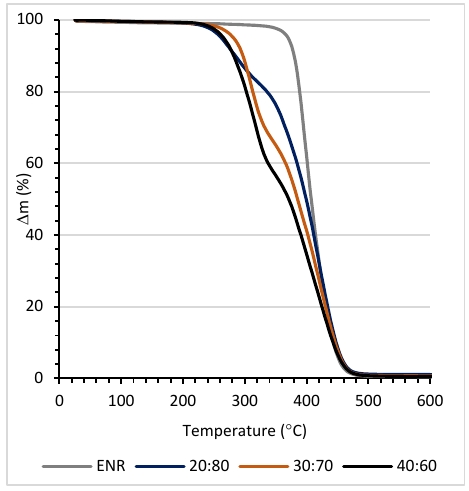
Figure 12. TGA curves of ENR and PLA/ENR blends. Table 2. Temperature of 5% weight loss T 5%, temperature of maximum weight loss of PLA phase T maxPLA , temperature of maximum weight loss of ENR phase T maxENR .